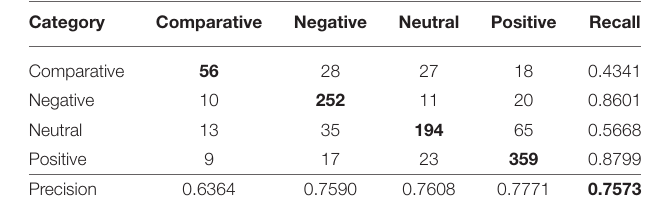
TABLE 10 | Confusion matrix for the tweets in the best combination, i.e., the CLMV feature set - Decision Trees classifier. Category